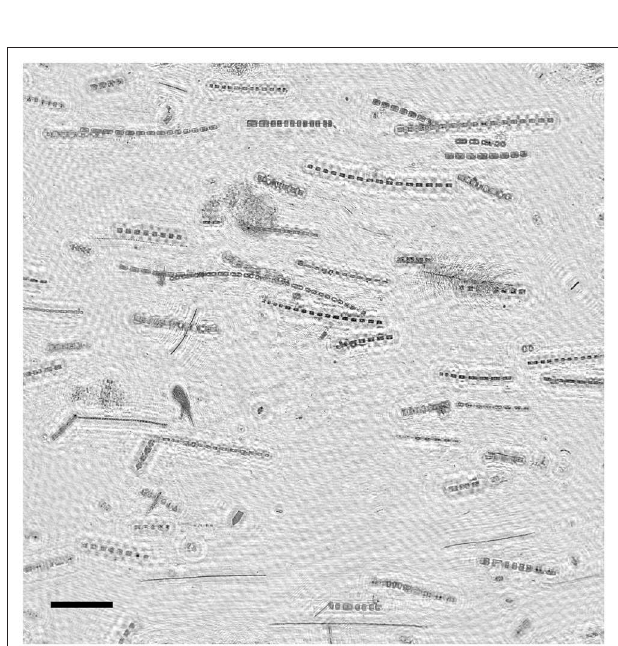
FIGURE 5 | Example extended depth of field image from the phytoplankton thin layer in profile C showing predominantly horizontal orientation of diatom colonies. Scale bar (lower left) represents 1